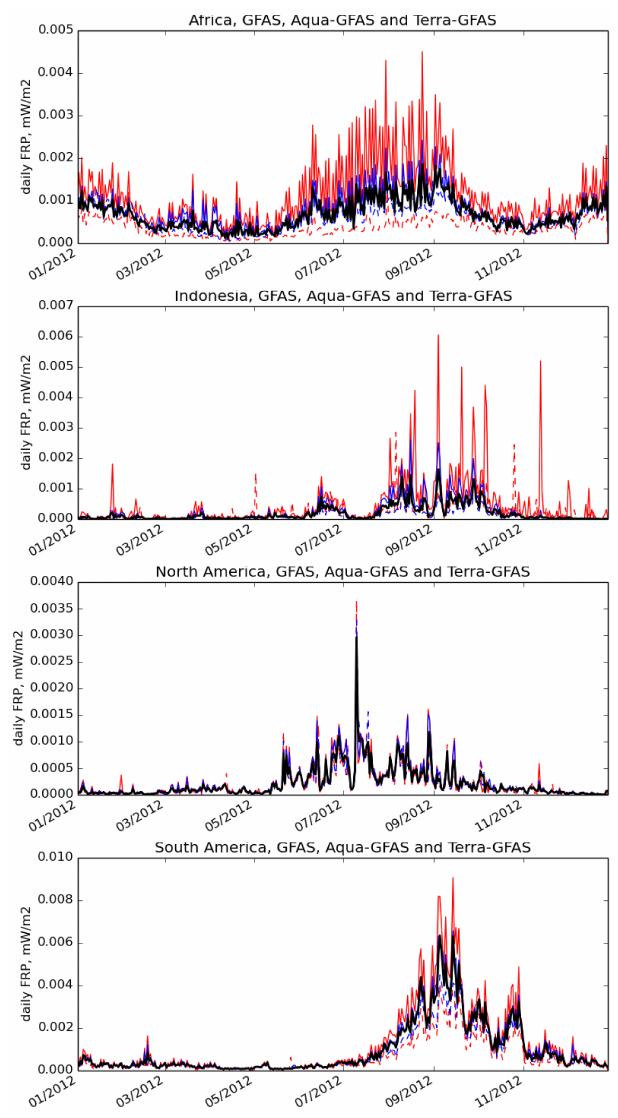
Figure 8. Daily FRP averaged of Africa (top), Indonesia (upper middle), North America (lower middle) and South America (bot- tom), for 2012. GFAS is shown in black (Aqua-GFAS as a solid line and Terra-GFAS as a dashed line), and using non-corrected obser- vations (red) and corrected observations (blue) and corrected obser- vations (blue) for Aqua-GFAS (solid line) and Terra-GFAS (dashed line).